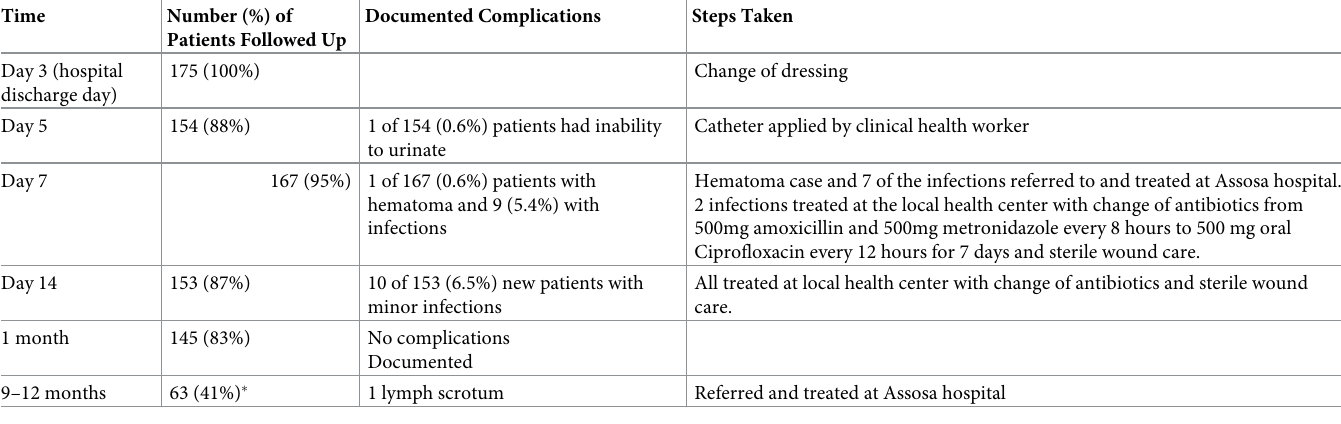
Table 3. Summary of post-operative complications and management. Time Number (%) of Documented Patients Followed Up